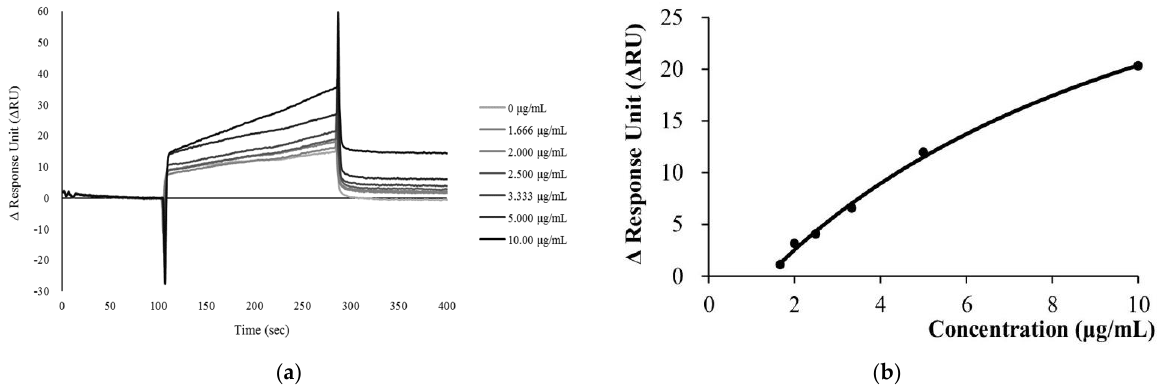
Figure 4. Analyses of kinetics and affinity of E6 protein and anti-HP-1 polyclonal antibodies. ( a ) The SPR Sensorgram showed that immobilized E6 proteins on the sensor chip and variant concentrations of anti-HP-1 IgY antibodies. ( b ) The analytes were flowed the chip through the anti-HP-1 polyclonal antibodies at various concentrations; the highest Δ RU achieved was plotted against its concentration. Table 2. Affinity analysis of immobilized of E6 protein and anti-HP-1 IgY antibodies with different Table 1. Kinetic analysis of immobilized of E6 protein and anti-HP-1 IgY antibodies with different concentrations.